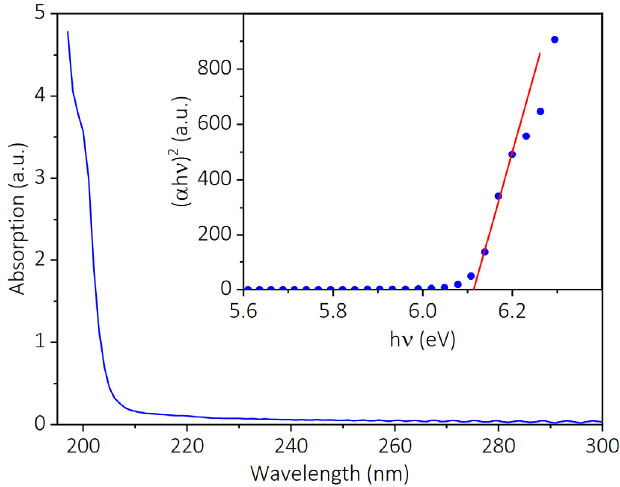
Figure 3. The absorption spectrum of the AlN sample. The inset is the corresponding Tauc plot.